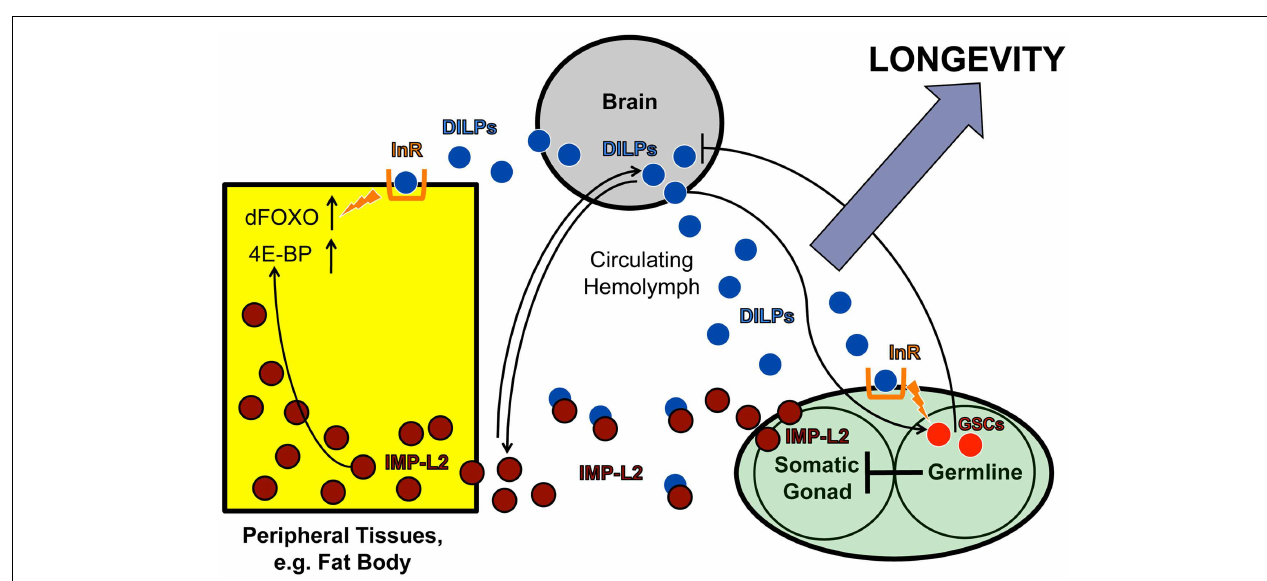
IMP-L2, which is known to inhibit aspects of insulin signaling. Remarkably, GSC ablation results in a strong upregulation of IMP-L2. Consistent with this observation, GSC ablation and IMP-L2 overexpression cause very similar phenotypes: in both cases, flies exhibit increased lifespan, upregulation of ilp2 , ilp3 , and ilp5 , and increased expression of DAF-16/FOXO targets (such as 4E-BP), although other aspects of DAF-16/FOXO activity (e.g., subcellular localization and phosphorylation status) remain unaltered.Together this suggests that the long-lifespan phenotype of GSC-ablated flies is mediated by IMP-L2, which in turn modulates insulin signaling. See text for further